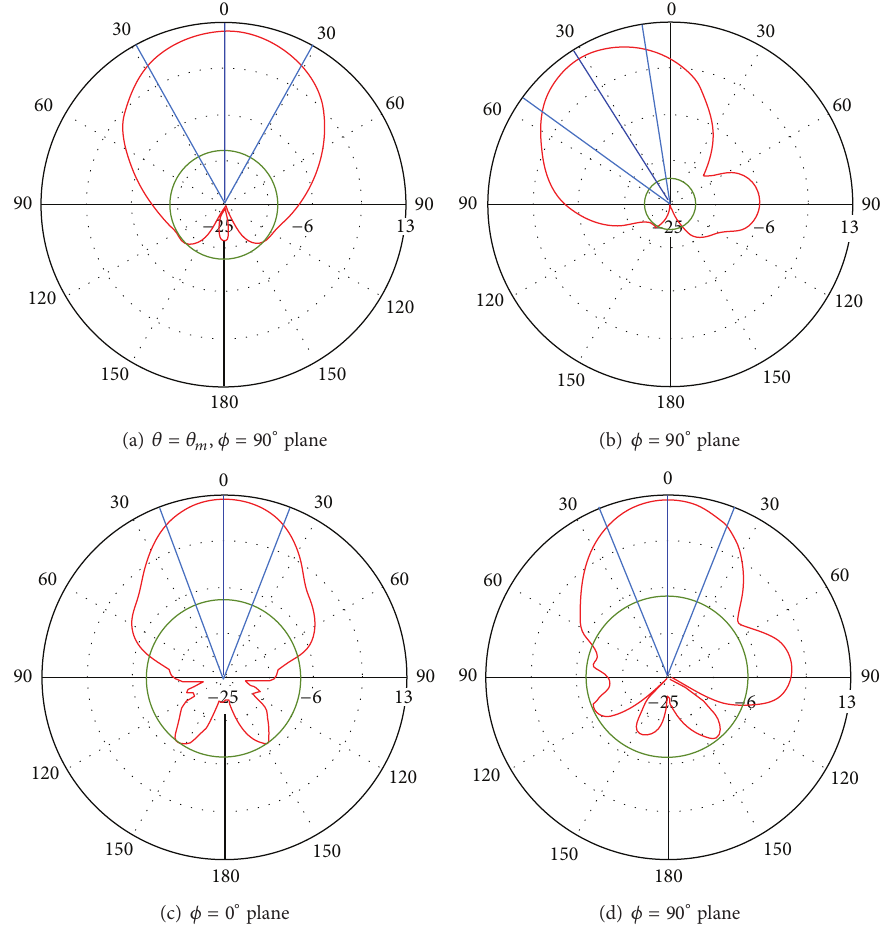
Figure 11: Bevel-cut simulated gain patterns using CST: (a) and (b) without adding the reflector and (c) and (d) after adding the